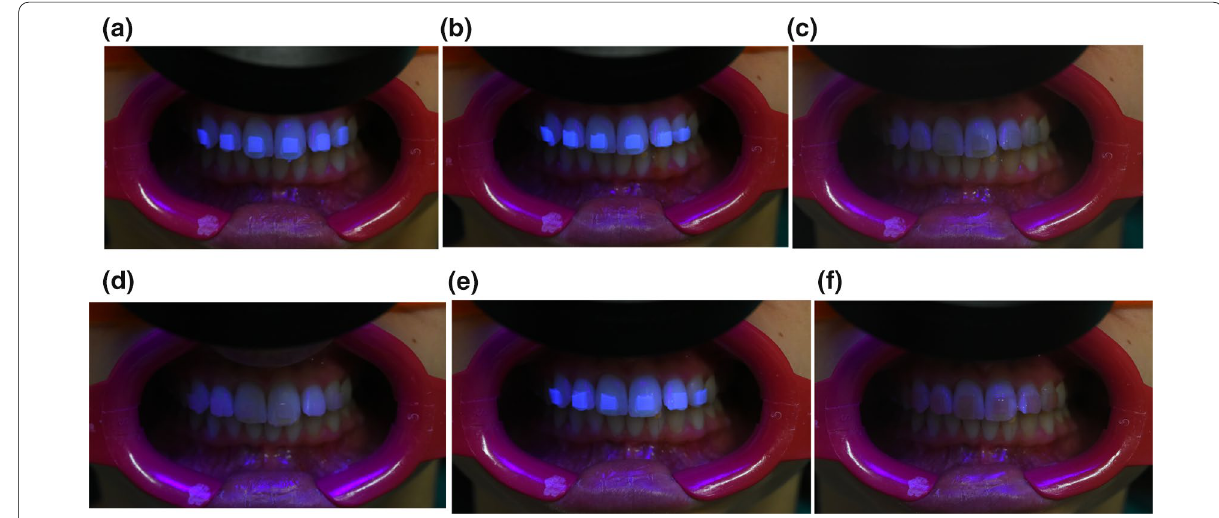
Fig. 4 The pictures obtained from the camera to assess brightness; a GC Ortho Connect; b Gradia Direct LoFlo; c Greengloo; d Transbond XT; e KommonBase Clear; f KommonBase